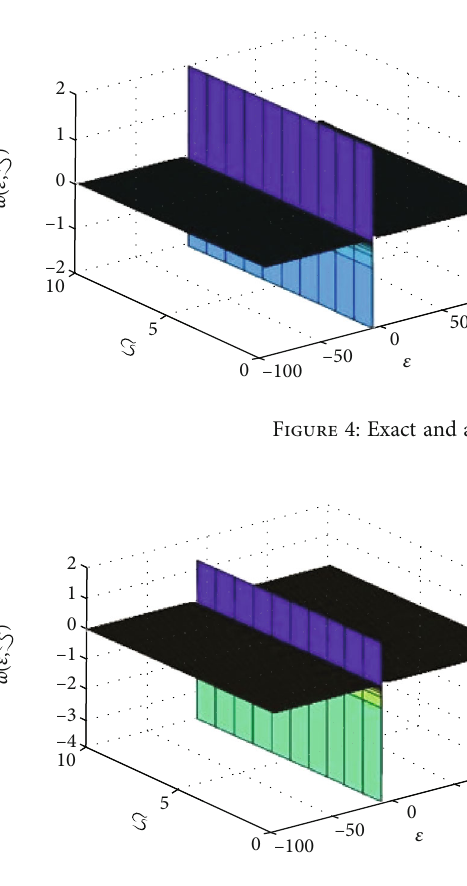
Figure 5: The di ff erent fractional-order of ϑ = 0 : 8 and 0 : 6 of the